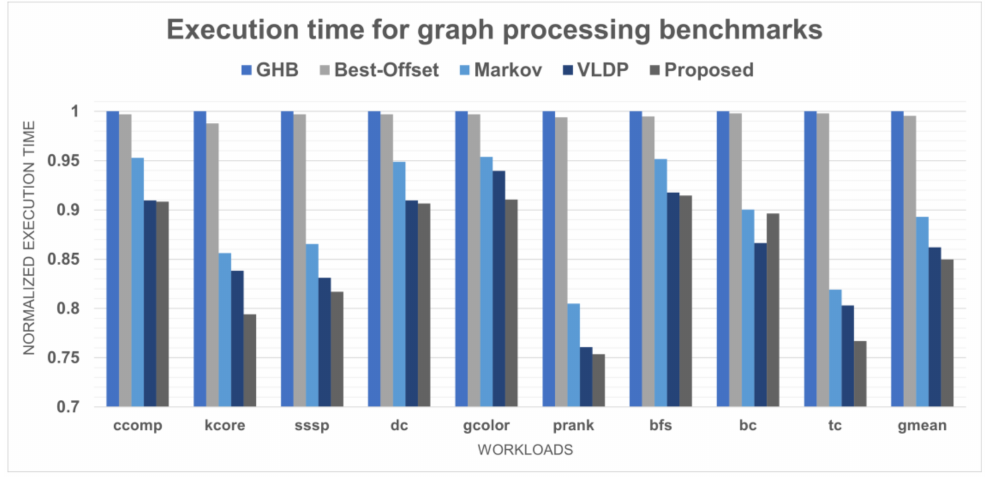
Figure 19. Execution time for graph processing workloads.